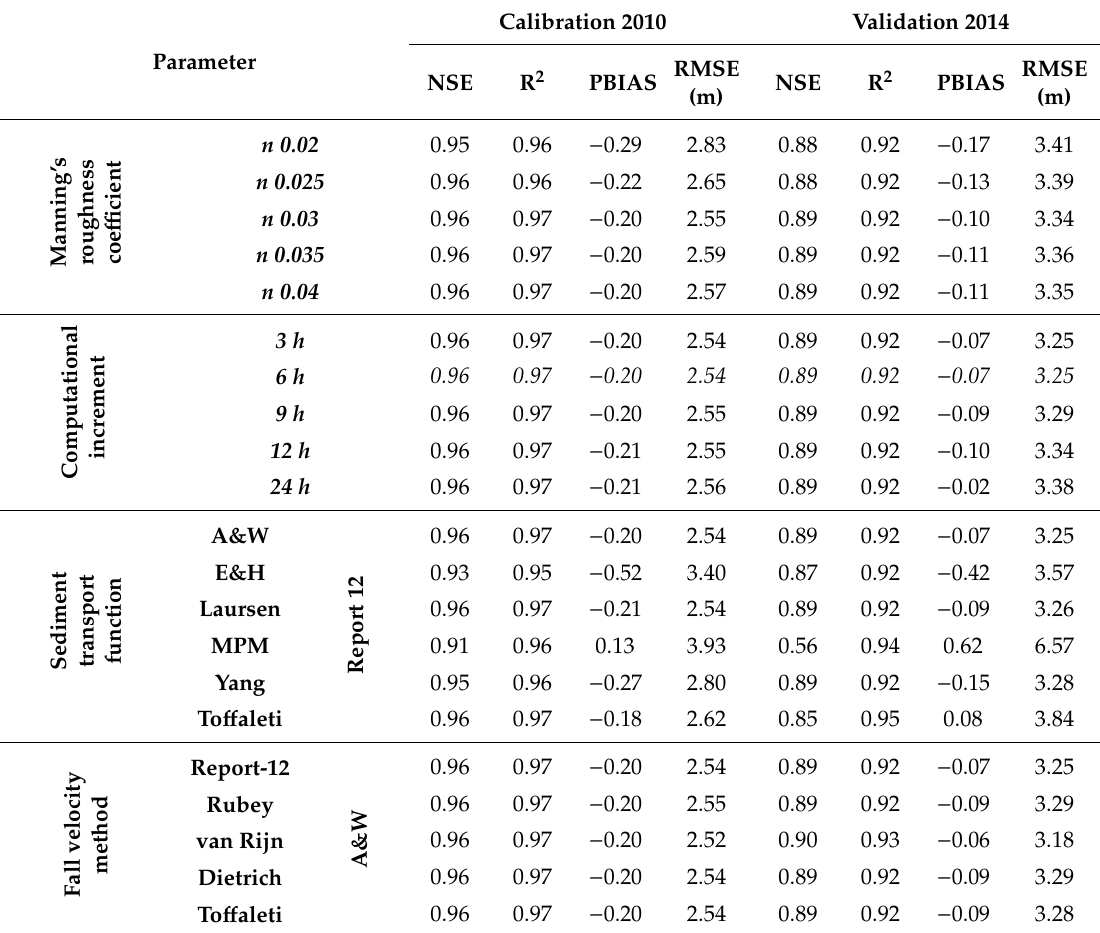
Figure 10. Comparison of observed and simulated bed elevation for different computational increments.